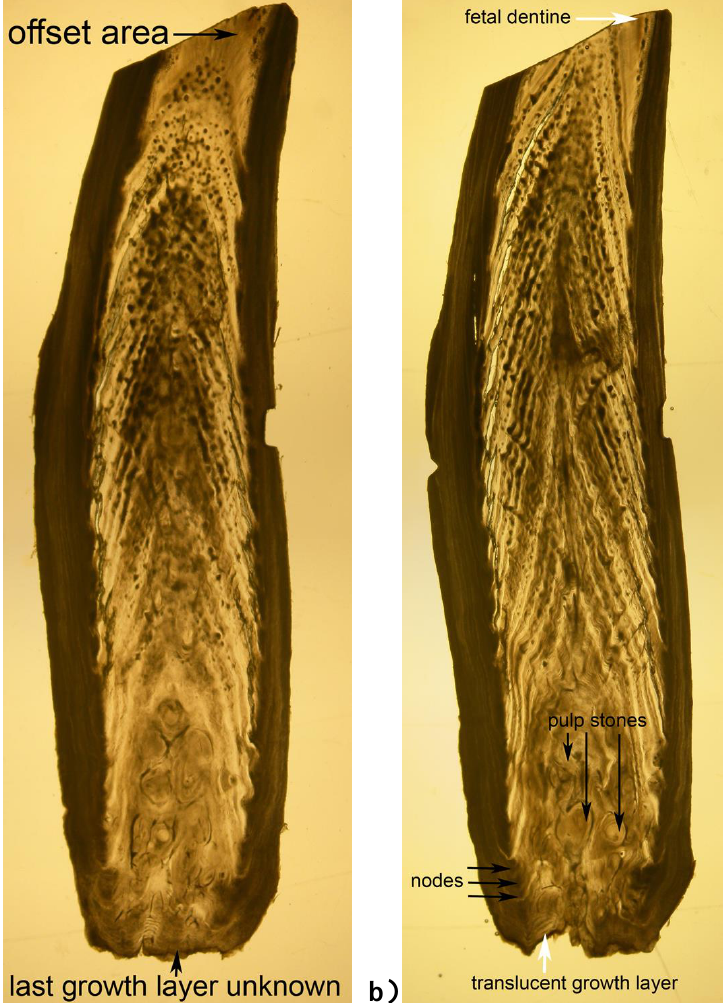
Fig. 6. Comparison of an off-set section and a median section of a tooth containing pulp stones. It helps interpretation to remember the section is a slice through the wall of a cone, and GLGs in a section passing through the vertex of each will appear ˄ -shaped, while GLGs in a parallel section through any other plane (i.e., either side of the midline of the tooth) will appear more ∩- shaped. a) AREP84-19, MNL-5; off-center section. In this off- center section, the growth layers at the cusp are indistinct because they are ∩ -shaped and opaque dentine underlies translucent dentine. In addition, fetal dentine is absent, the root tip is challenging to interpret, and the last growth layer deposited cannot be determined. This section is not suitable for generating an age estimate. b) AREP84-19, MNL-5 alternate; median section. In this median section, the cone was sectioned near its vertex and most of the opaque dentine lies at right angles to the viewed surface. The fetal dentine is present and a translucent growth layer is apparent adjacent to some portions of the pulp cavity. The growth layer pattern is challenging and, while nodes assist counting GLGs, the age estimate is a minimum because some portions of the section cannot be